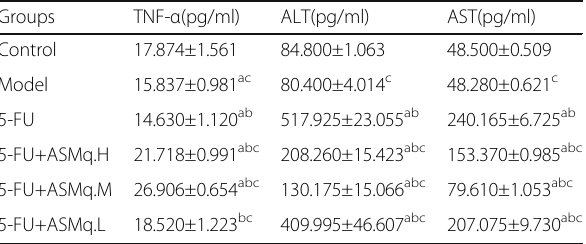
Table 4 The effects of 5-FU combined with Abnormal Savda Munziq on the expression of ALT, AST and TNF- α in mice serum ( x ± s